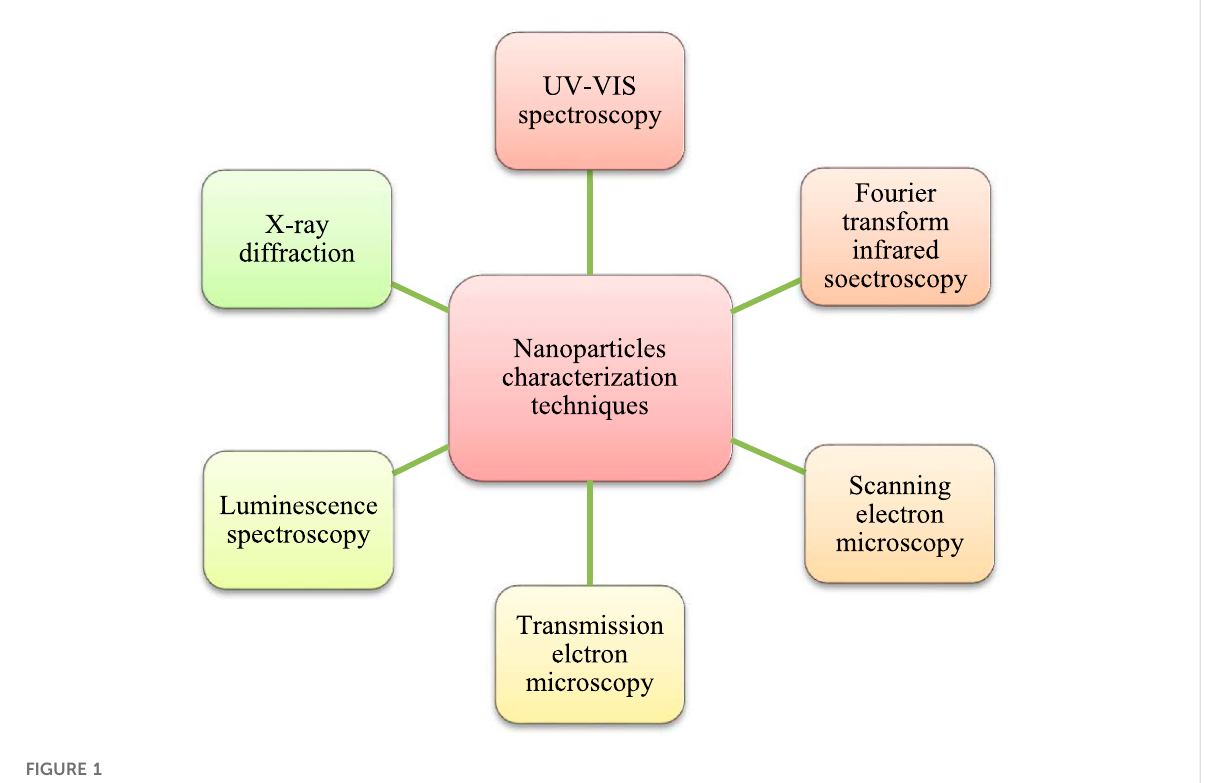
FIGURE 1 Different characterization techniques for metalloid